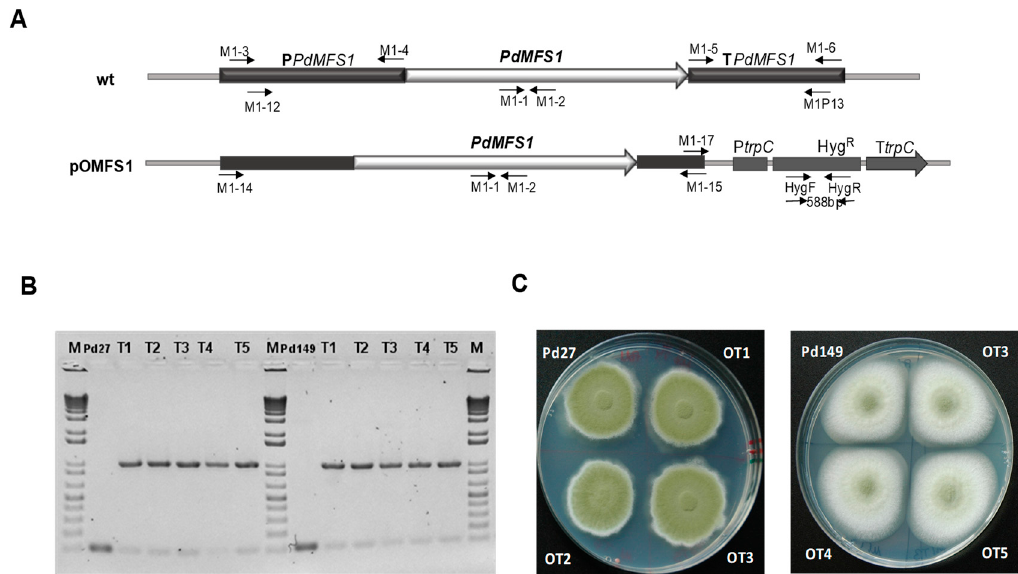
Figure 3. Construction and analysis of P. digitatum overexpression PdMFS1 transformants. ( A ) Map of plasmid pOMFS1. Diagram of wild-type locus and the PdMFS1 gene with the HygR selectable marker from pOMFS1 inserted elsewhere in the genome. Primers used in the construction of plasmid pOMFS1 and those used for the analysis of the transformants are shown. ( B ) Hygromycin polymerase chain reaction (PCR) analysis of the Pd27 wild type and Pd27-transformants, Pd149 wild type Pd149, and 149-transformants using primers HygF / HygR. Lanes correspond to WT: DNA from Pd27 strain, T1–T5: Pd27-overexpressed mutants and WT: DNA from Pd149 strain, T1–T5: Pd149-overexpression mutants. ( C ) Phenotypical features and conidiation. Fungal strains grown in PDA plates at 25 °C during six days.